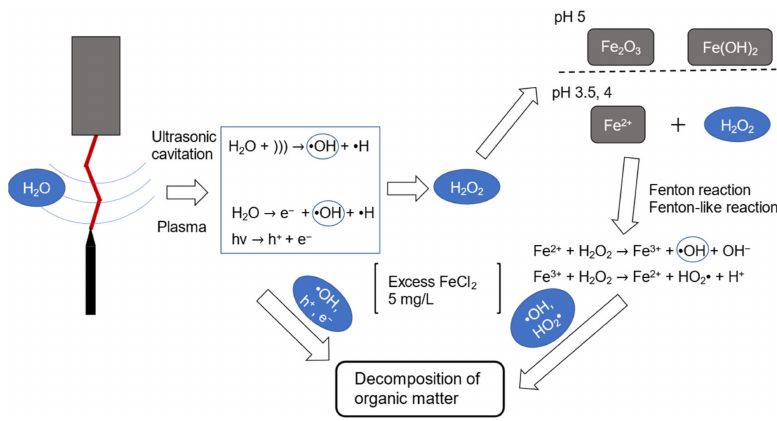
Figure 7. Possible mechanisms of rhodamine B decomposition.